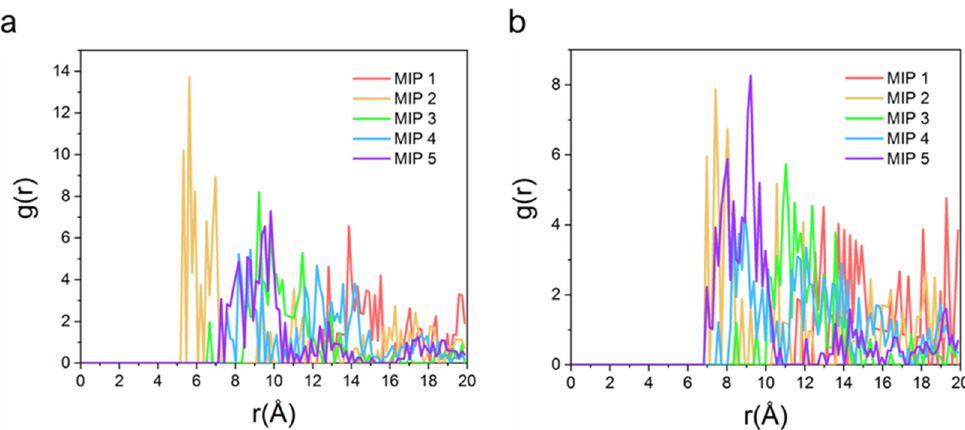
Figure 5. RDFs of ( a ) TH − MO1 and ( b ) TH − MO2. g(r) shows the RDF values, while r(Å) represents the distance from a solute atom and the average bulk atom.